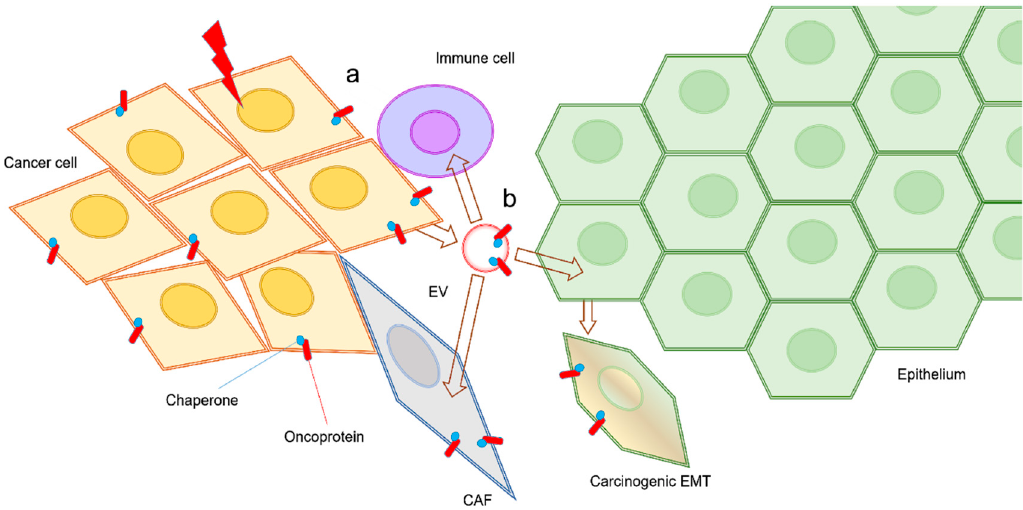
Figure 2. Exosome-mediated carcinogenic transfer. ( a ) Cancer cells (orange diamonds) and/or CSCs also known as CICs can express oncoproteins (red bars) such as mutant or amplified receptor tyrosine kinases (RTKs) including EGFR family members, which are functionalized by molecular chaperones HSPs (blue balls). ( b ) The carcinogenic and resistance factors of EVs can be transferred to epithelial cells (green hexagons) and initiate carcinogenic EMT [31]. These factors carried by EVs can be transferred to and alter CAFs (gray diamond) and immune cells (shown in purple) such as TAMs. The EV-mediated transfer of carcinogenic factors and HSPs is a novel mechanism of cancer expansion and malignant conversion of the tumor microenvironments leading to a resistant phenotype.